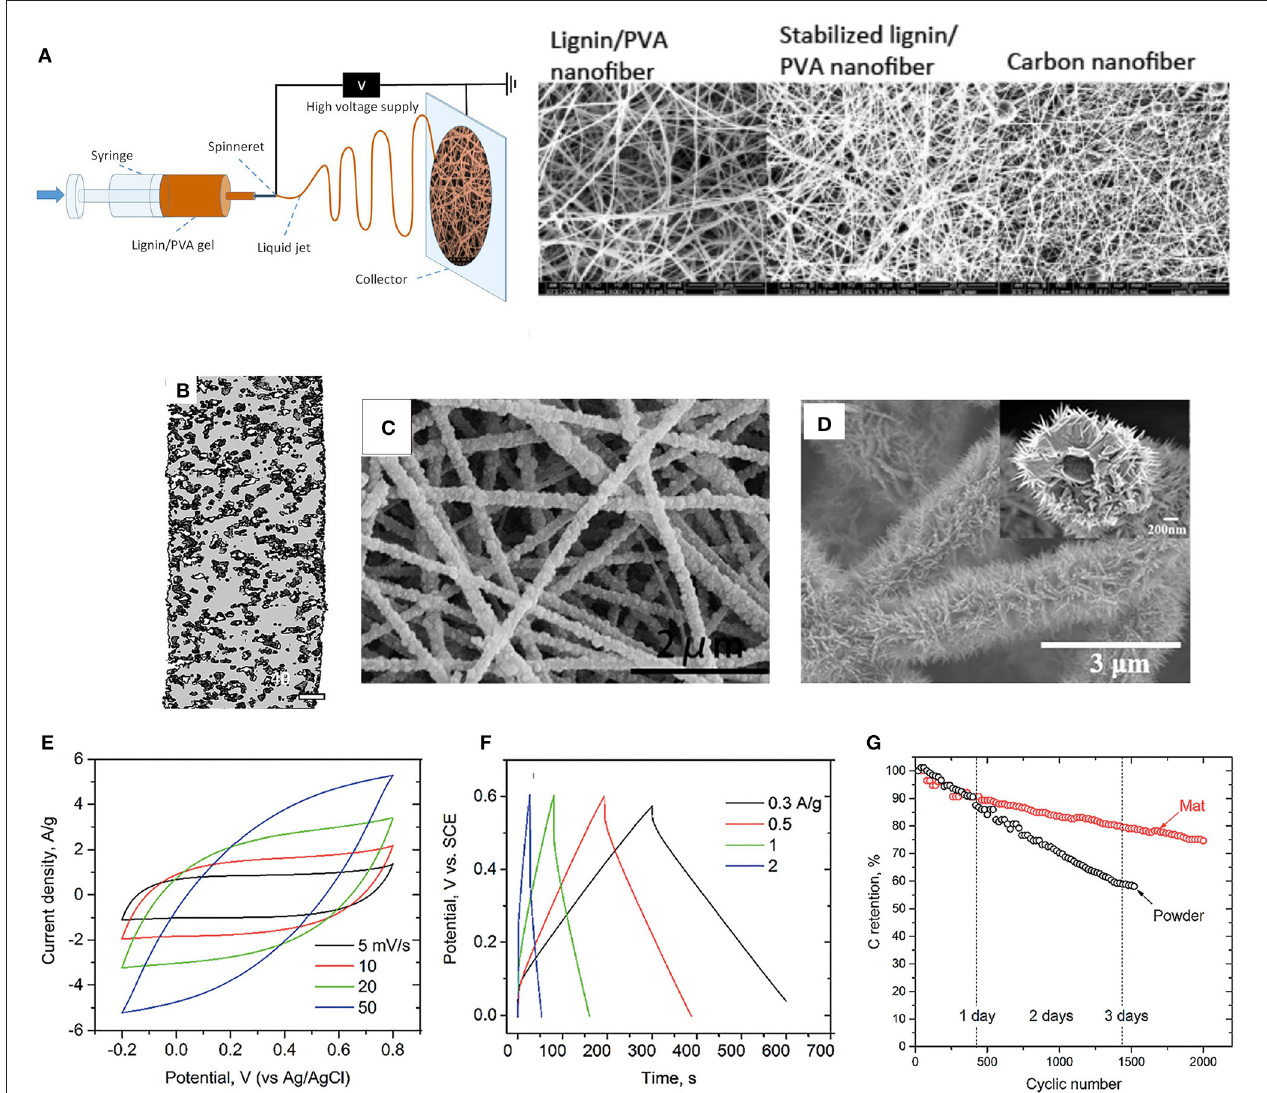
FIGURE 1 | Preparation of lignin-based electrospun carbon nanofibers (ECNFs), their structure and electrochemical properties. (A) Schematic of electrospinning of the lignin/PVA suspension (75/25) and electrospun lignin/PVA nanofibers before post-processing, after stabilization, and after carbonization; (B–D) methods which are used to reach very high specific surface area on the carbon fibers: (B) KOH treatment prior the carbonization process resulting in a mesoporous carbon nanofiber by Ago et al. (2016) reproduced under the terms of the Creative Commons Attribution (CC BY 3.0) license, (C) magnesium nitrate treated ECNFs resulting in carbon nanofibers with improved porosity, surface area and electrochemical performance by Ma et al. (2018) with permission from Elsevier, (D) nickel cobaltite (NiCo 2 O 4 ) decorated ECNFs which resulted in high specific surface area and high specific capacitance by Lei et al. (2017) with permission from Elsevier; (E–G) electrochemical characterization of lignin-based ECNFs as electrode material using three-electrode cell configuration in 0.5M Na 2 SO 4 electrolyte by Ago et al. (2016) reproduced under the terms of the Creative Commons Attribution (CC BY 3.0) license: (E) cyclic voltammograms at varying scan rates; (F) galvanostatic charge/discharge curve at varying current densities, (G) cycling stability of ECNFs and powder at 10mV s − 1